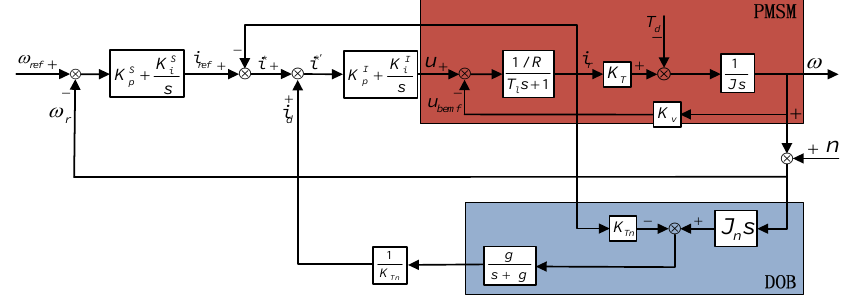
Figure 3. Simplified control block diagram of an inverter compressor with a general disturbance observer